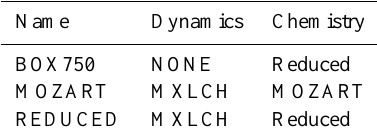
Table 3. Overview